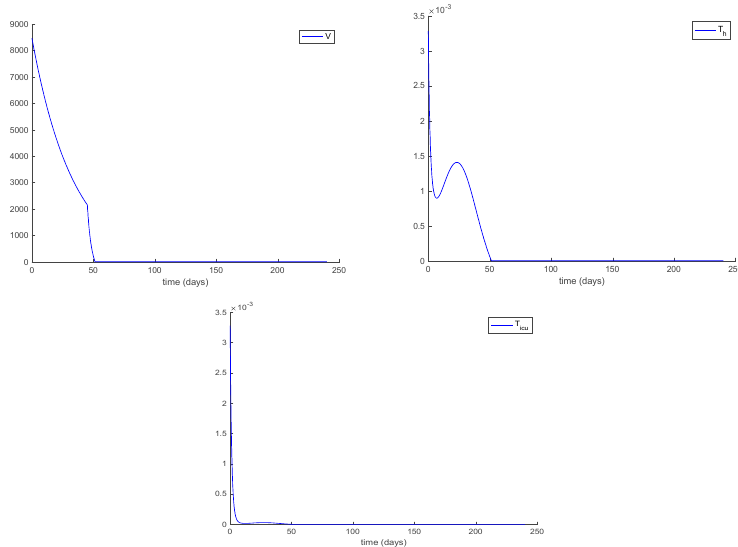
Figure 4. Control efforts corresponding to each action. Figure 4. Control e ff orts corresponding to each